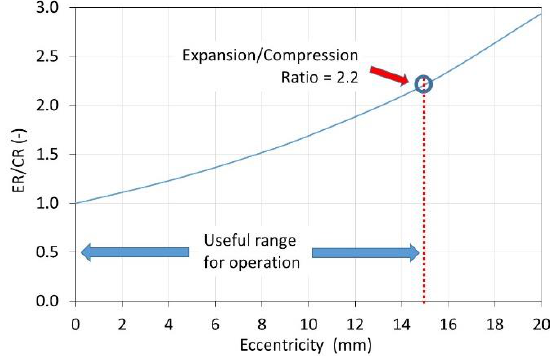
Fig. 11. Expansion to compression ratio vs. eccentricity Fig. 8. Piston distance from TDC The maximum for the eccentricity is limited by the power drop generated by the engine. As shown in Fig. 12, additional power generated by the engine increases with increase in eccentricity and indirectly with increase in ex- pansion/compression ratio. As analyzed, the maximum limit for the ER/CR is 2.2, that corresponds to the eccen- tricity of approximately 15 mm.